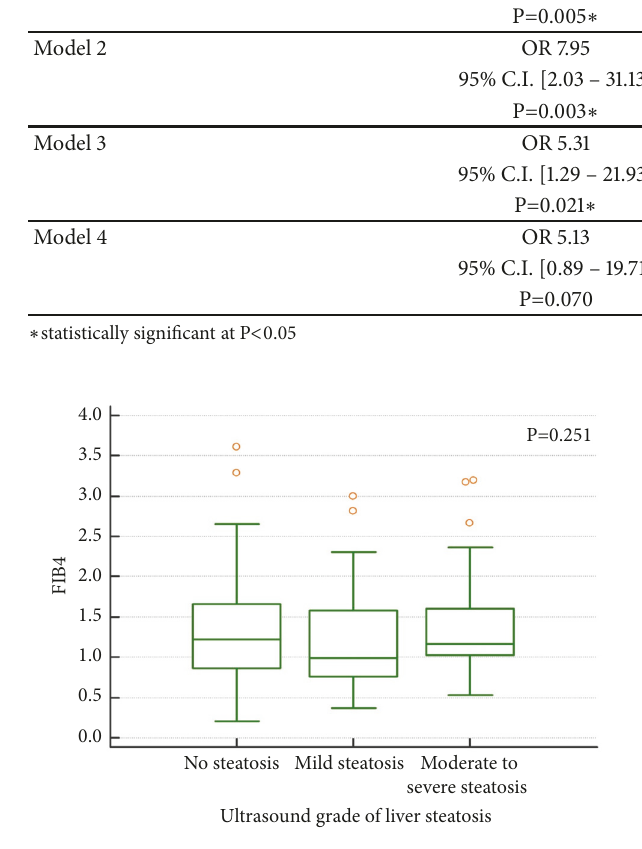
Figure3:Fibrosis-4(FIB4)scoredidnotsignificantlydifferbetween different grades of liver steatosis, the Kruskal-Wallis ANOVA test,